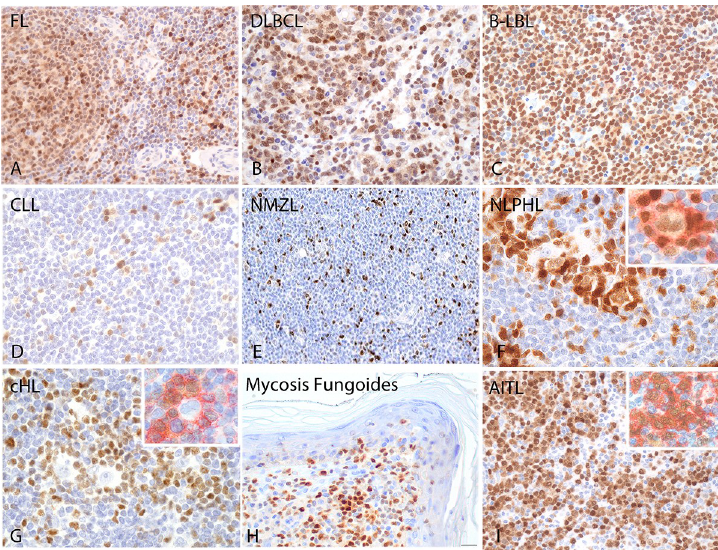
Fig 5. TOX expression in B and T-cell lymphomas. Strong TOX expression was found in the nuclei of tumor cells in FL (A), DLBCL (B) and precursor B-LBL (C). In CLL (D) and NMZL (E) TOX was found in the tumor microenvironment. In NLPHL (F) TOX was expressed by L&H cells and in the PD1+ rosette surrounding the tumor cells as shown by the double immunoenzymatic staining of TOX and PD1 (red) (upper image F and G). In cHL (G) TOX was found only in the tumor microenvironment. MF and AITL and MF also expressed high level of TOX (H and I). Double immunoenzymatic staining confirmed the expression of TOX [25] in PD1+ (red) in AITL tumor cells (inset image